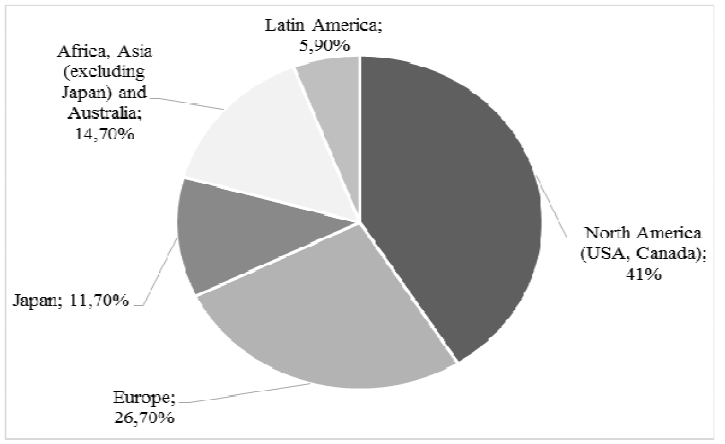
Source: Adapted from Efpia and IMS MIDAS 2013 (Data Relate to the 2012 Audited Global Retail Pharmaceutical Market at Ex-Factory